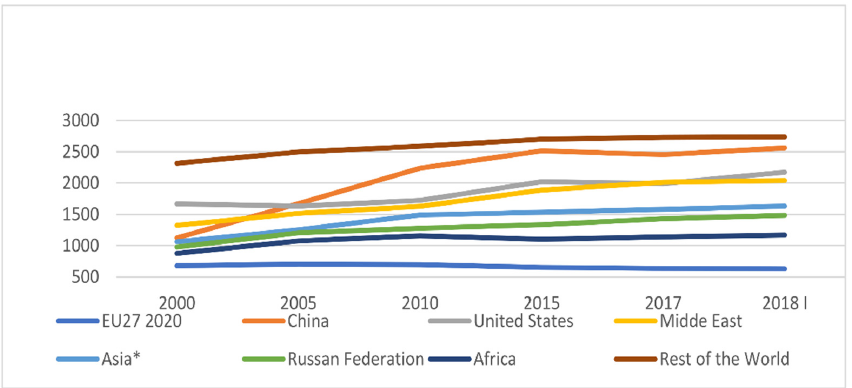
Figure 1. World Energy Production by Region in Mtoe. Source: EU energy in figures Statistical Pocketbook 2019.